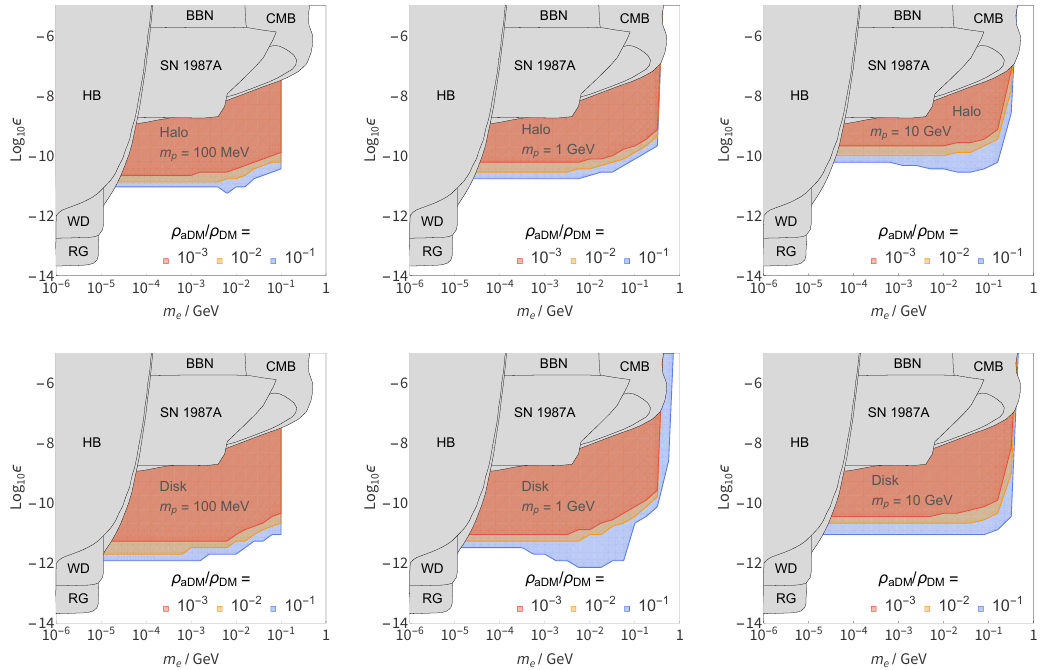
Figure 6 . Constraints on (cid:15) as a function of m ˜ e , for three different values of the dark proton mass and α = α , assuming halo-like aDM velocity distribution (above) and the disk-like velocity D em distribution (below). The constraints shown here are from cooling of horizontal branch (HB) stars, white dwarfs (WD) and red giants (RG) [63, 68–71], ∆ N at BBN and CMB times [71], and from eff supernova 1987A [60]. Note that in the first column the constraints are cut off at m = 100 MeV, ˜ e since the dark electron is defined to be always lighter than the dark proton. For heavier dark protons, the constraints die off due to inefficient bremsstrahlung for high electron masses and therefore low ionization fractions.